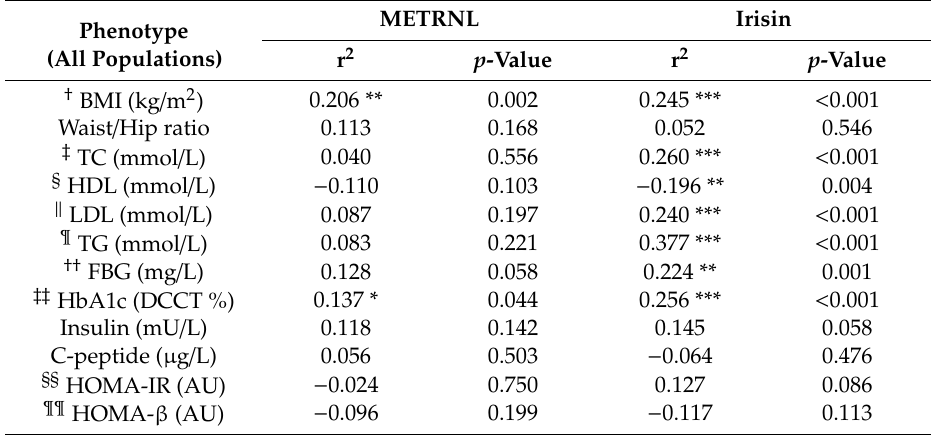
Table 4. Correlation between circulating METRNL and irisin proteins and physical, clinical, and biochemical parameters in all population adjusted for age and gender.